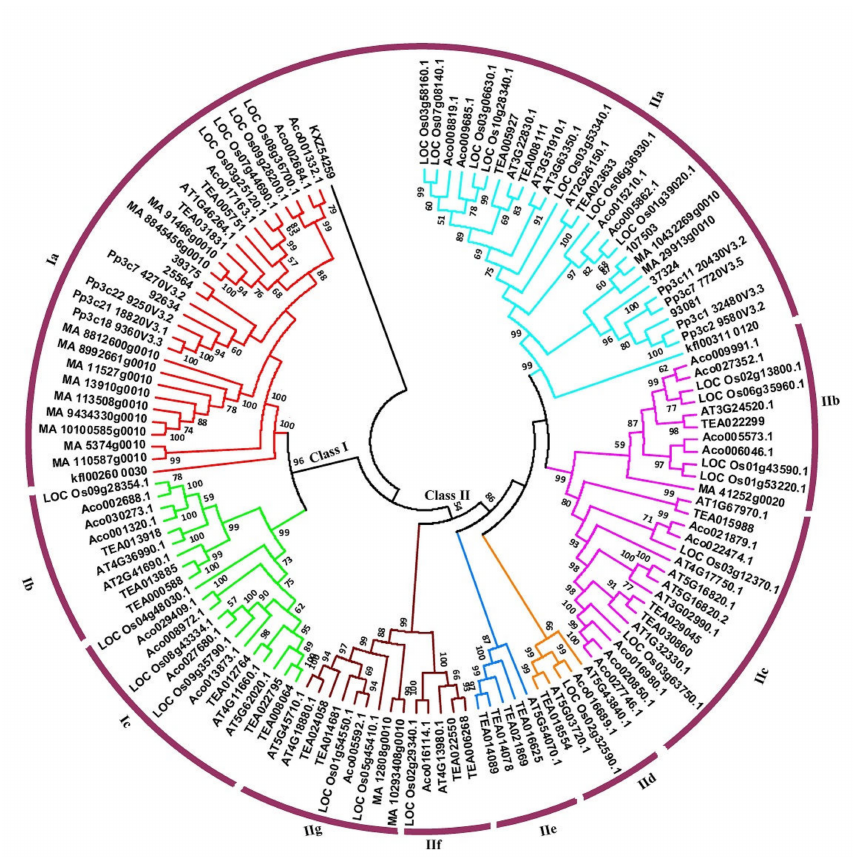
Figure 2. Phylogenetic tree of Hsf in plant species. Phylogenetic tree of Hsf proteins in tea plant and other plant species were generated by MEGA 7 using neighbor-joining. TEA: Camellia sinensis , At: Arabidopsis thaliana , Loc_Os: Oryza sativa , MA: Picea abies , Pp: Physcomitrella patens , Kf: